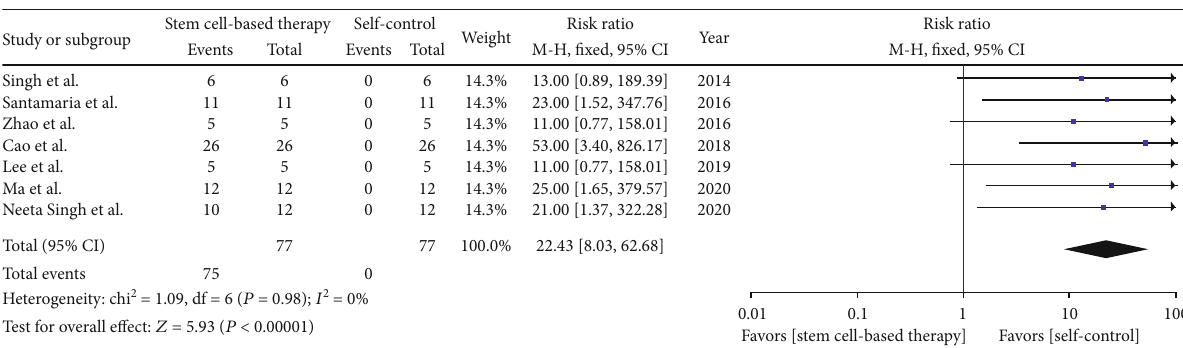
Figure 2: Menstruation